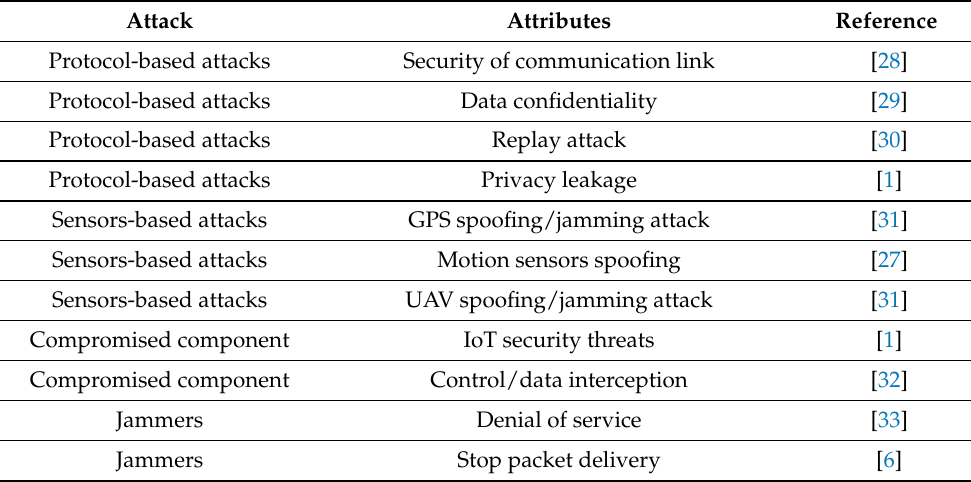
Table 1. UAV security comparative analysis.